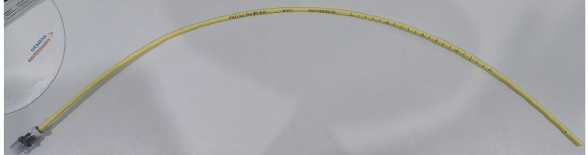
Figure 2: Airway exchange catheter (AEC) used to change the endotracheal tube (ETT).